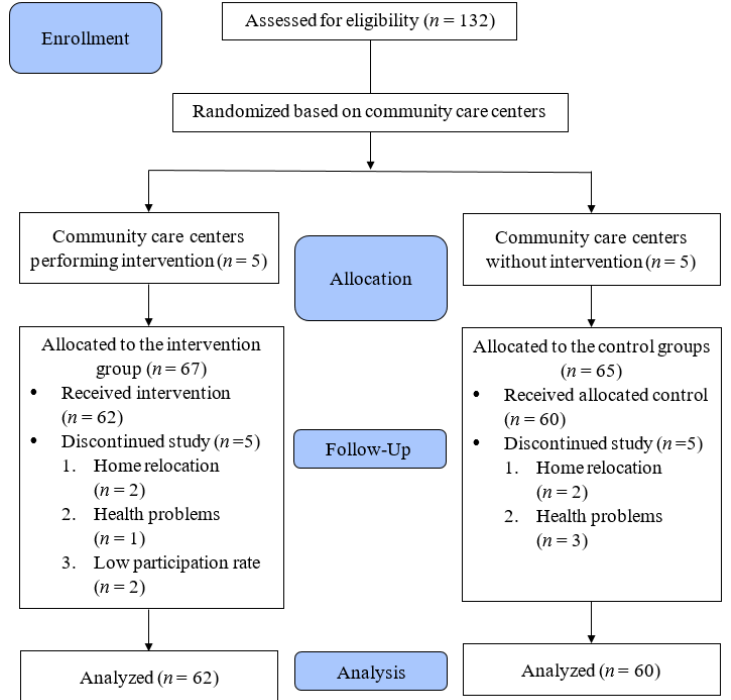
Figure 1. Flow chart of the participants through the study.